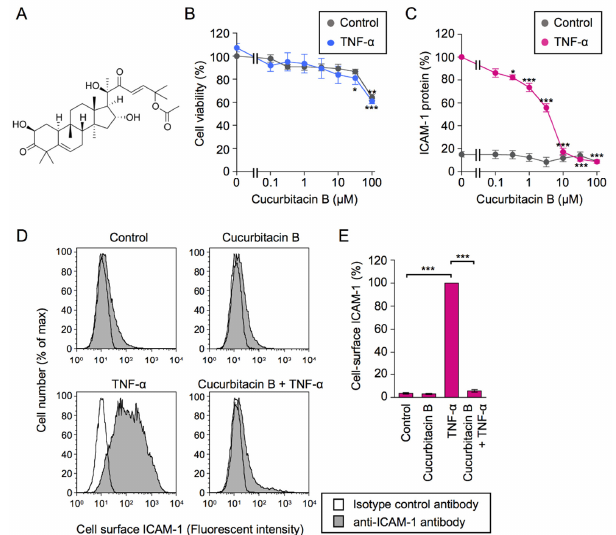
Figure 1. Cucurbitacin B down-regulated TNF-α-induced cell-surface ICAM-1 expression. ( A ) Figure Structure of cucurbitacin B. ( B , C ) A549 cells were pretreated with serial dilutions of cucurbitacin B for 1 h and were then treated with (blue circles in ( B ) and red circles in ( C )) or without (gray circles) TNF-α (2.5 ng/mL) in the presence of cucurbitacin B at the indicated final concentrations for 6 h.